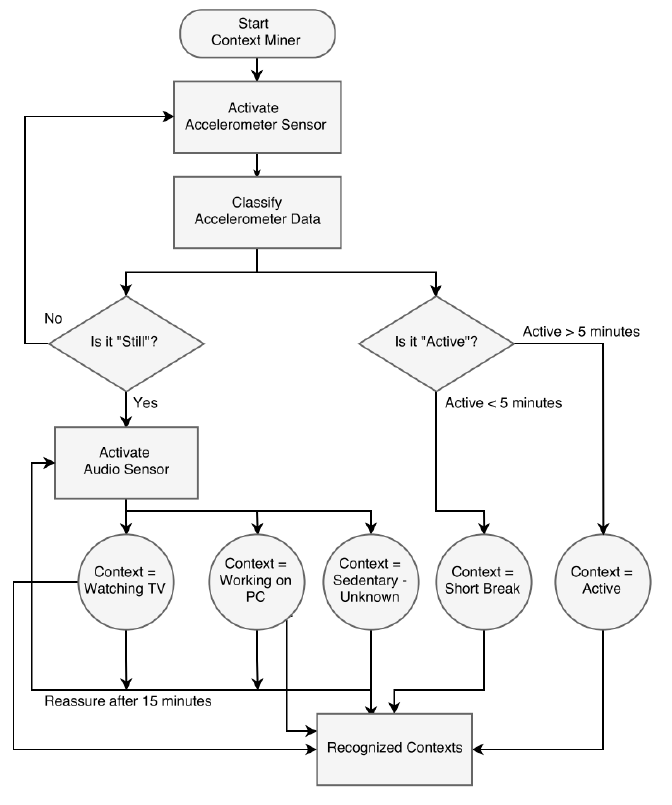
Figure 5. Flowchart of the context miner